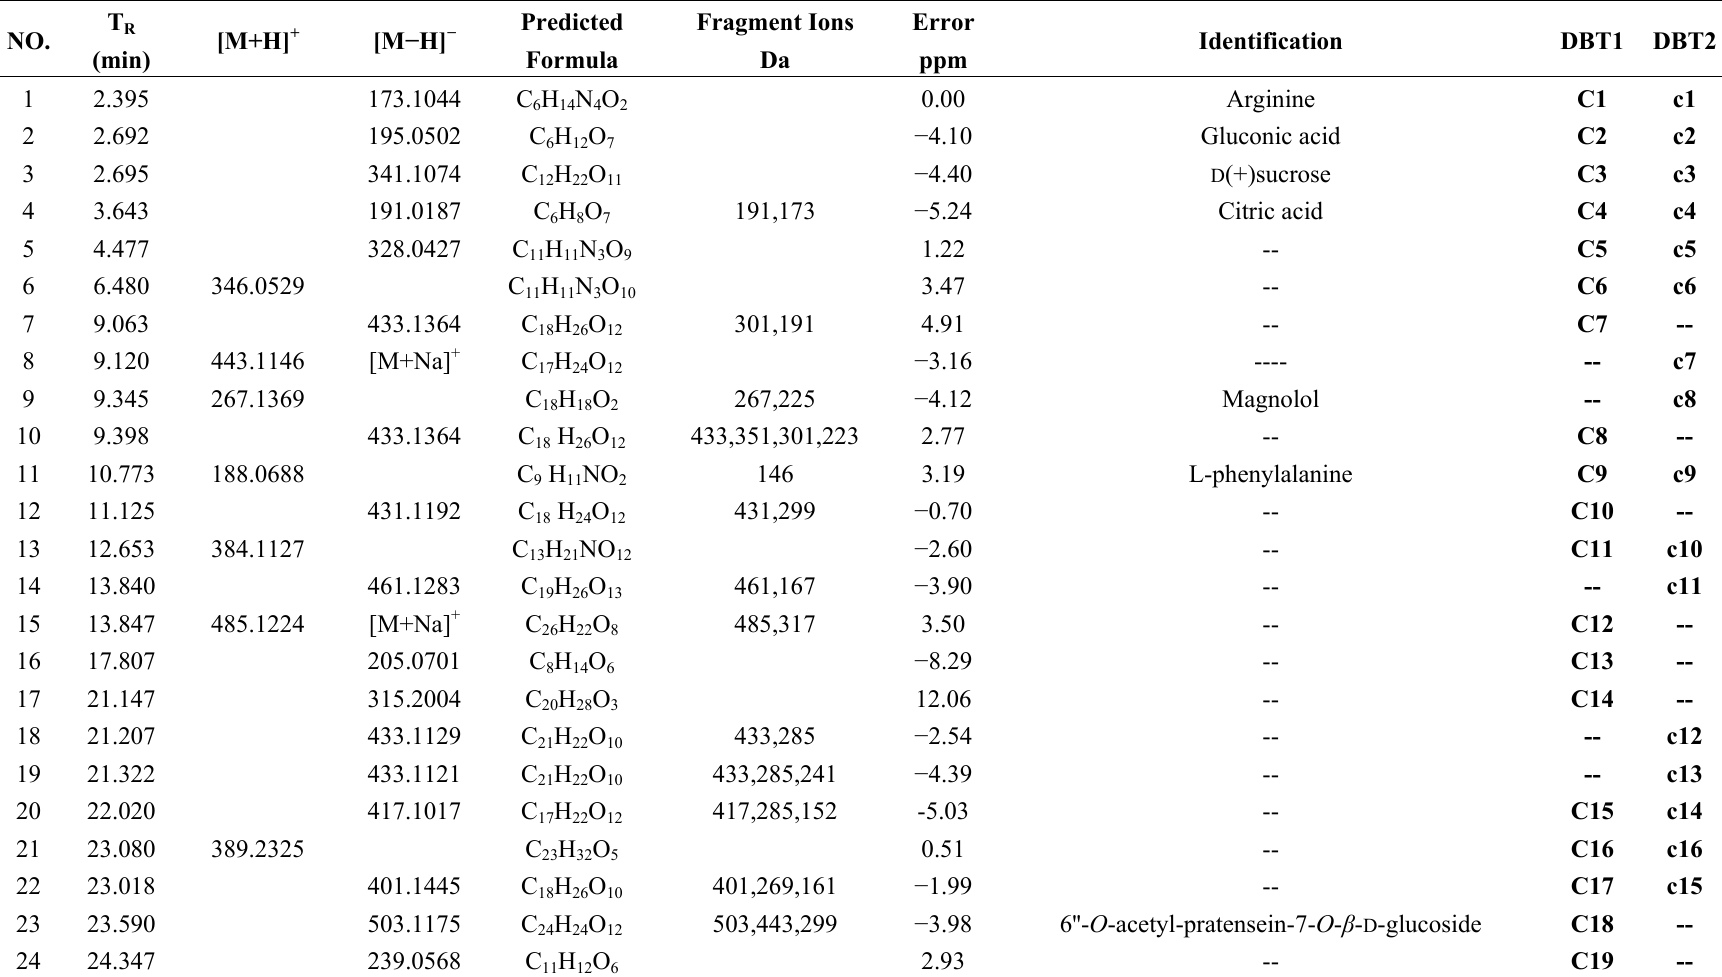
Table 2. The identified proposed compounds of the crude extract samples from Danggui Buxue Tang 1 and Danggui Buxue Tang 2 by HPLC-DAD-ESI-IT-TOF-MS n